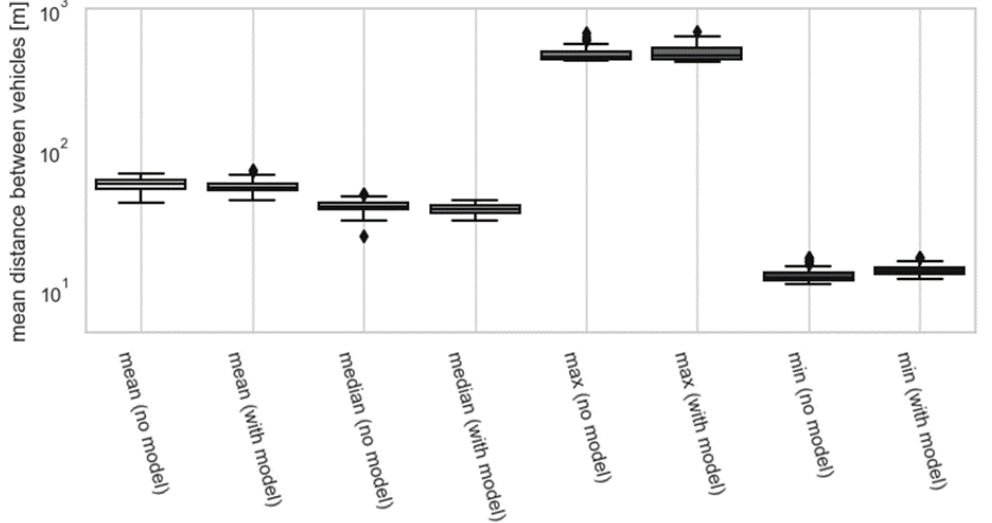
Figure 3. The result obtained for drivers reaction time, equal to 850 ms and traffic intensity of 400 vehicles per hour.